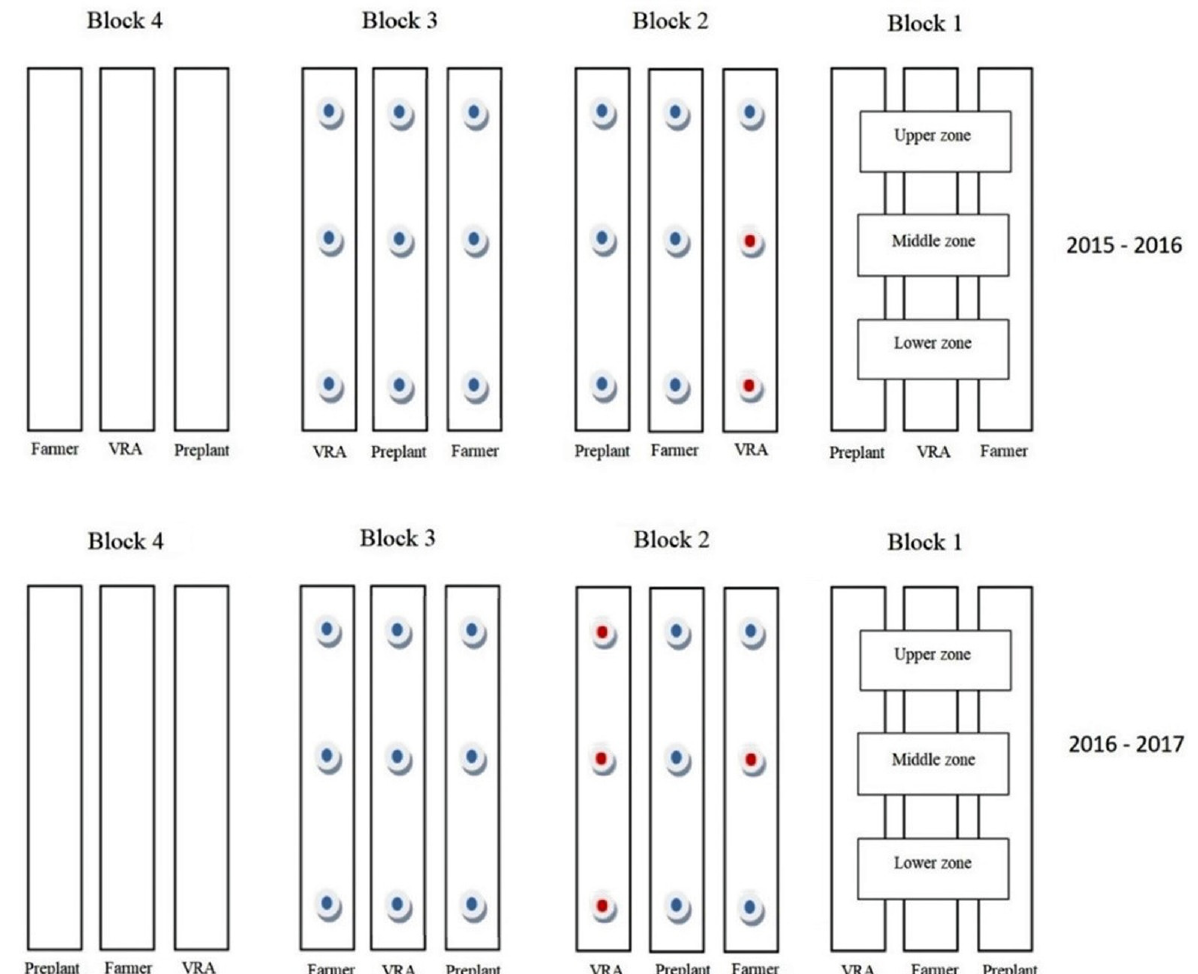
Figure 3. Experimental design for 2015–2016 and 2016–2017 growing seasons. Blue points represent a soil moisture sensor at 30 cm depth. Red points represent a station of five soil moisture sensors monitoring 1 m depth.